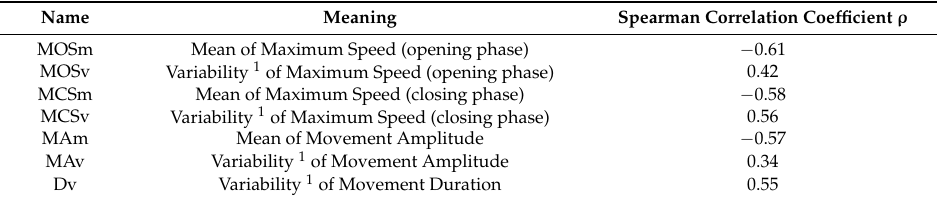
Table 4. List of significant parameters for Opening Closing task.